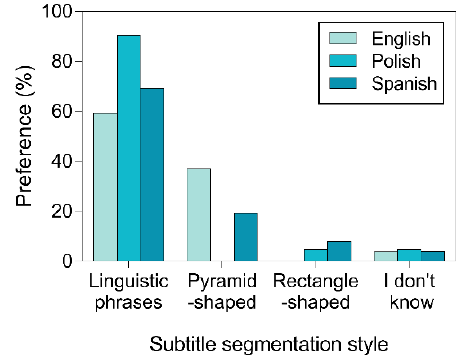
Figure 4. Segmentation preferences by group and style.